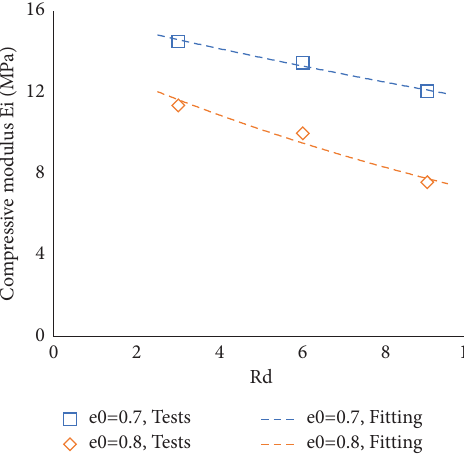
Figure 8: E − R i d relationship for PTFE ball heaps.